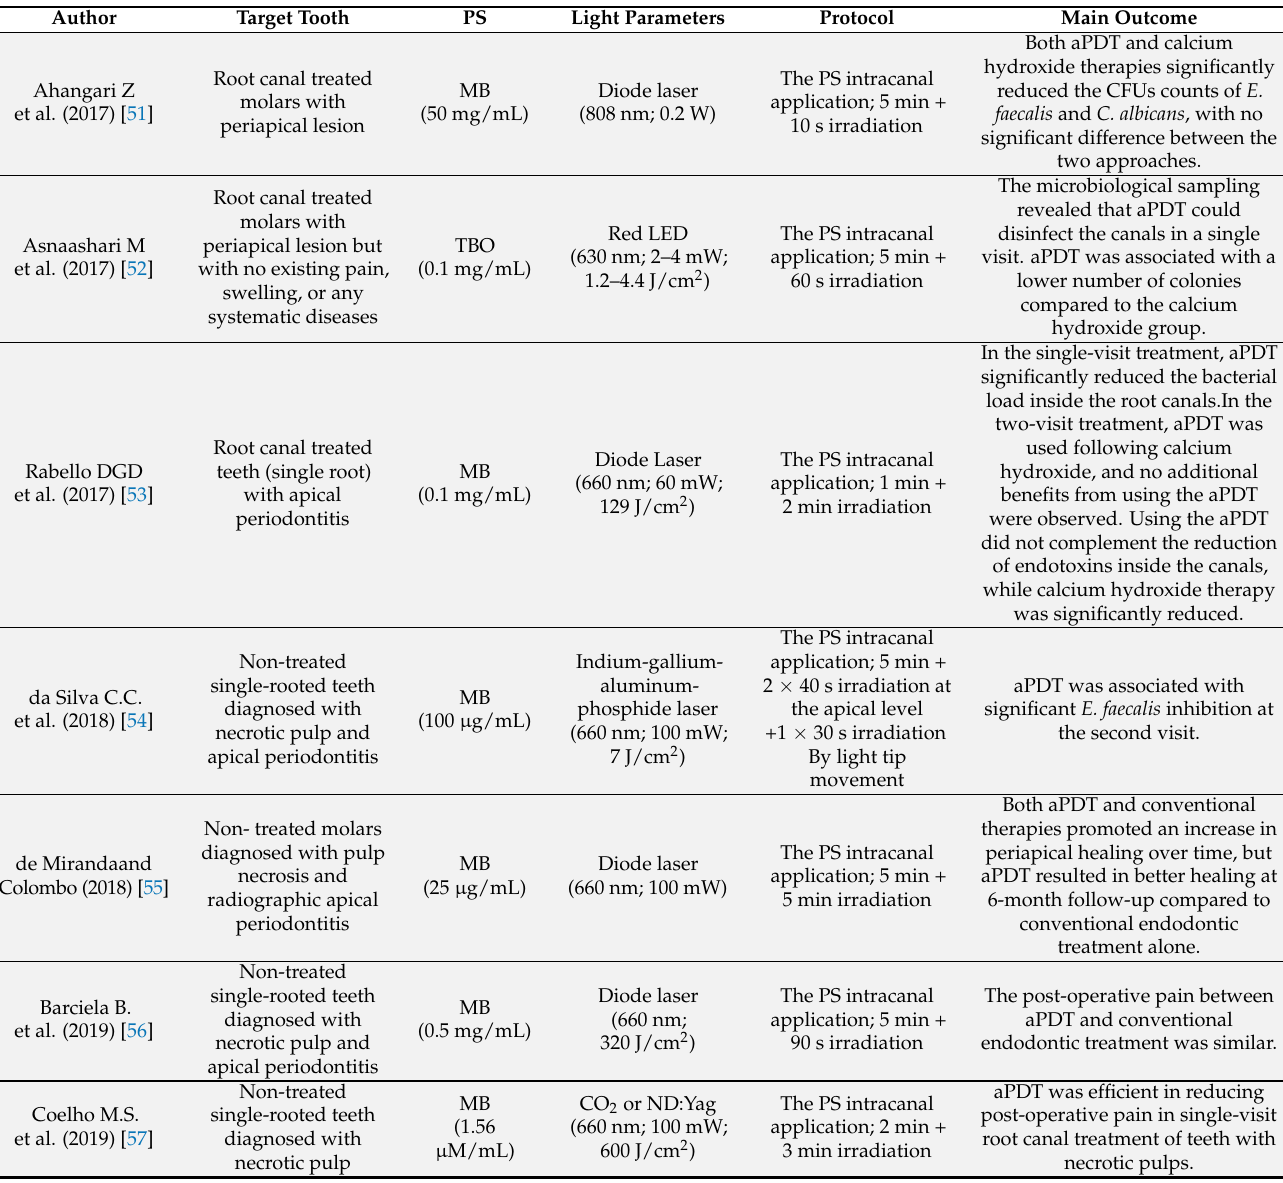
Table 2. Summary of the randomized clinical trials reporting aPDT outcomes against endodontic